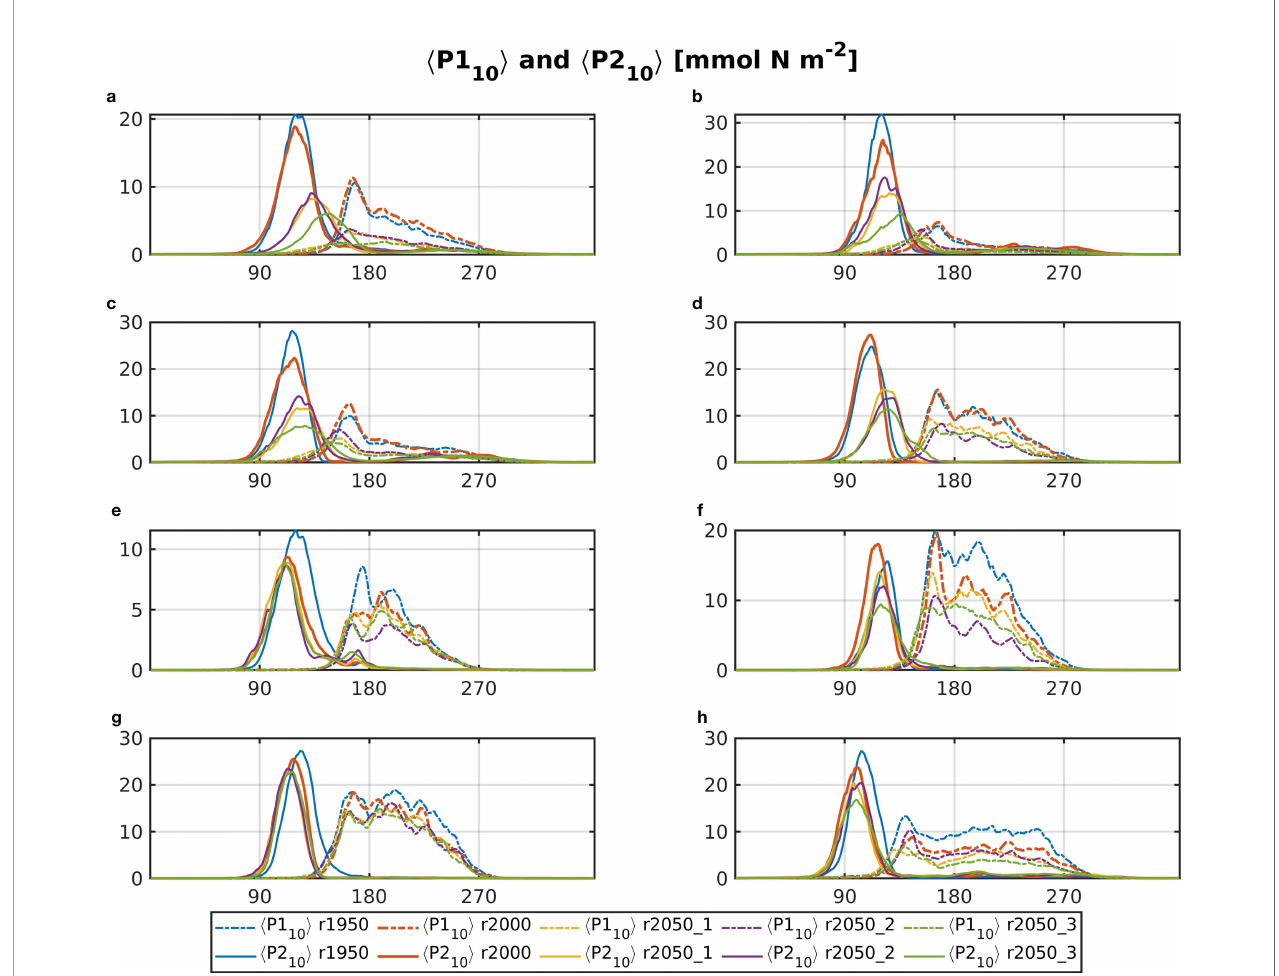
FIGURE 4 | Daily climatology of <P1> 10 (dotted dashed) and <P2> 10 (solid) for all base runs (blue: r1950, red: r2000, yellow: r2050_1, purple: r2050_2, green: r2050_3). The letter tags in the panel ’ s titles refer to the areas, which are shown in Figure 1